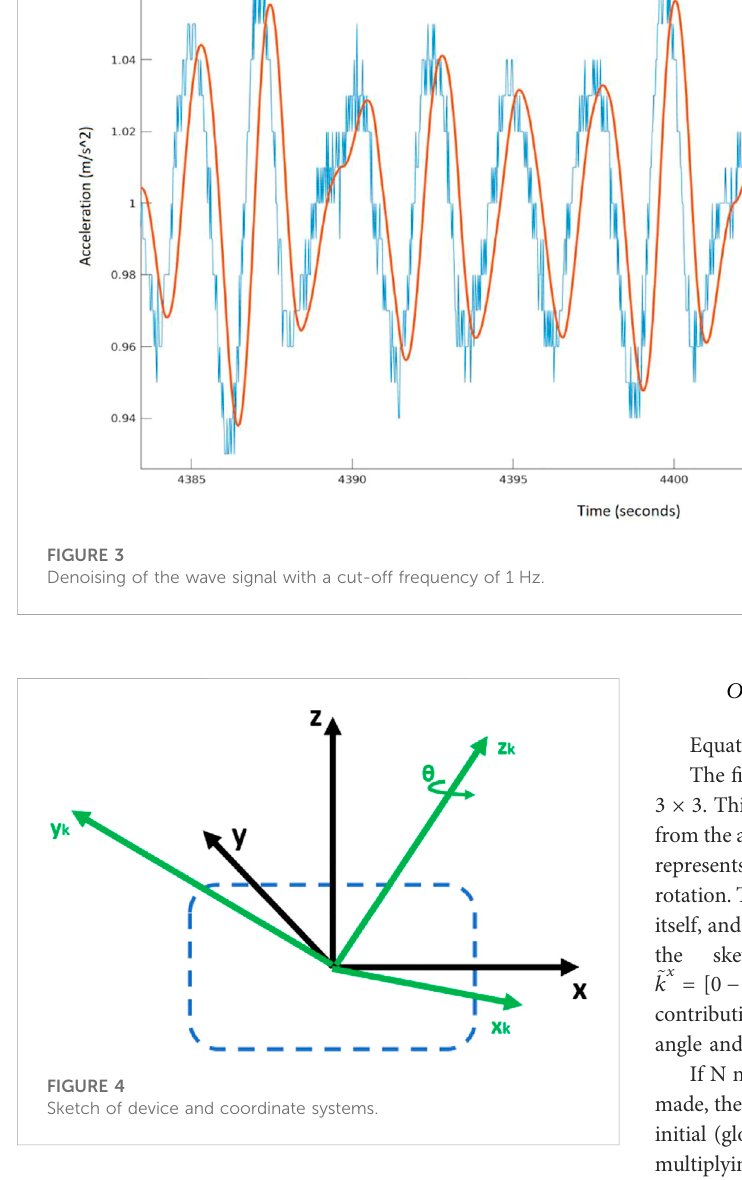
Equation 3: Rotation of the fi nal coordinate system with respect to the initial (global).